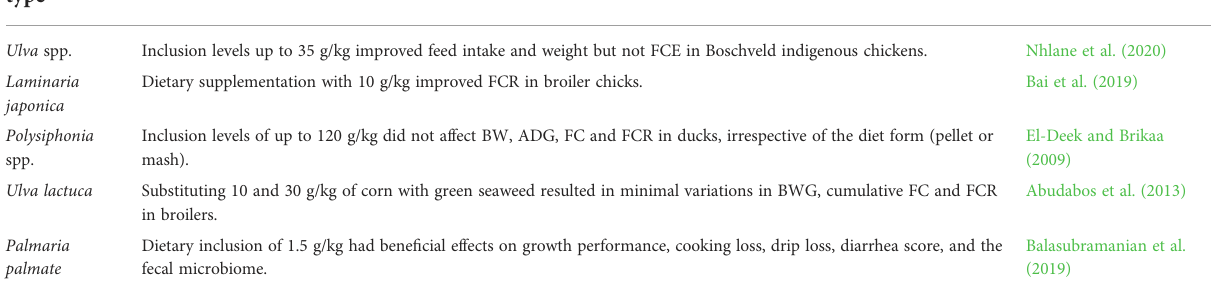
TABLE 4 Some biological effects of including seaweeds in poultry